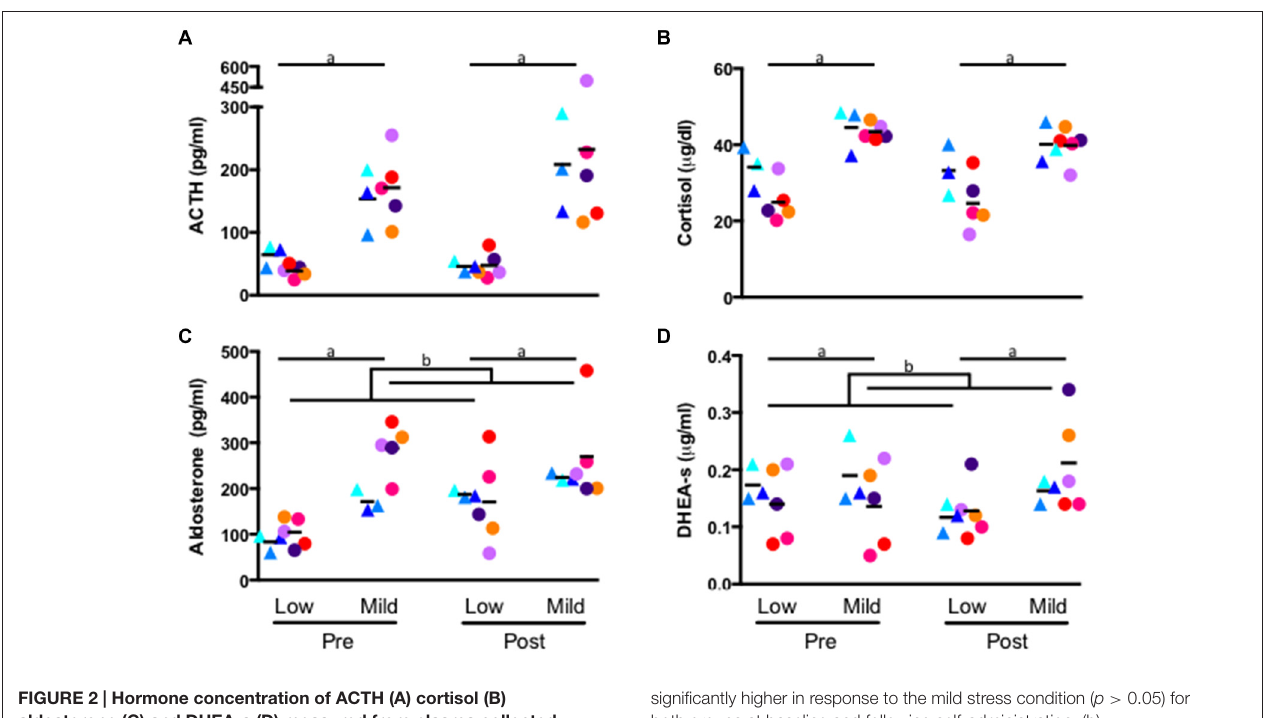
FIGURE 2 | Hormone concentration of ACTH (A) cortisol (B) aldosterone (C) and DHEA-s (D) measured from plasma collected in the home-cage (low stress) and from a primate chair (mild stress). Samples were assayed prior to self-administration (pre), and following self-administration (post). (a) All hormone concentrations were